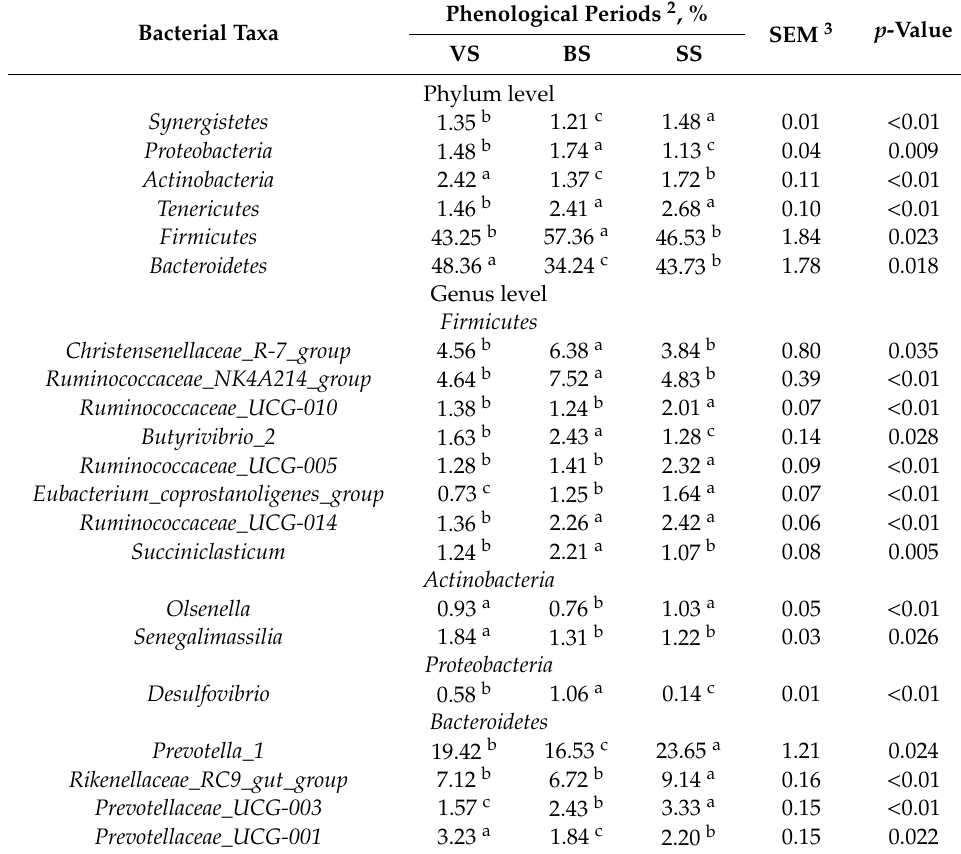
Table 5. Comparison of rumen bacterial phylum and genera 1 in di ff erent phenological